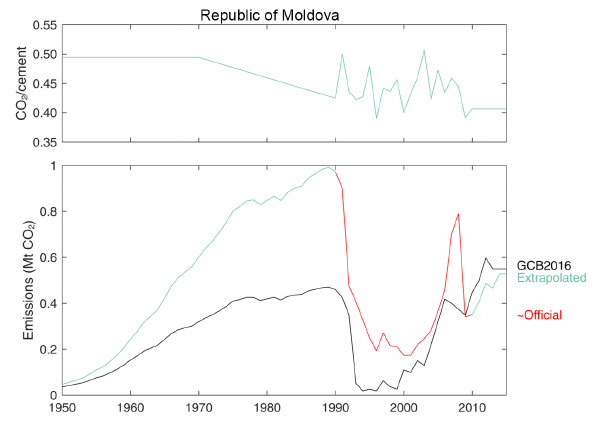
Figure C27. Revised cement emissions for Moldova.